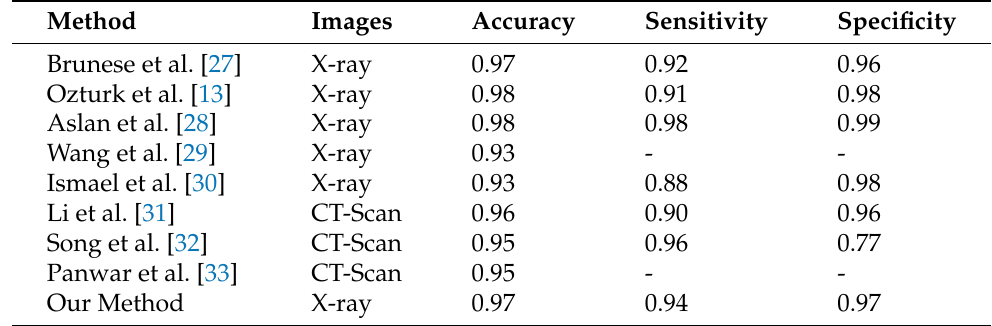
Table 3. Comparison between various COVID-19 detection